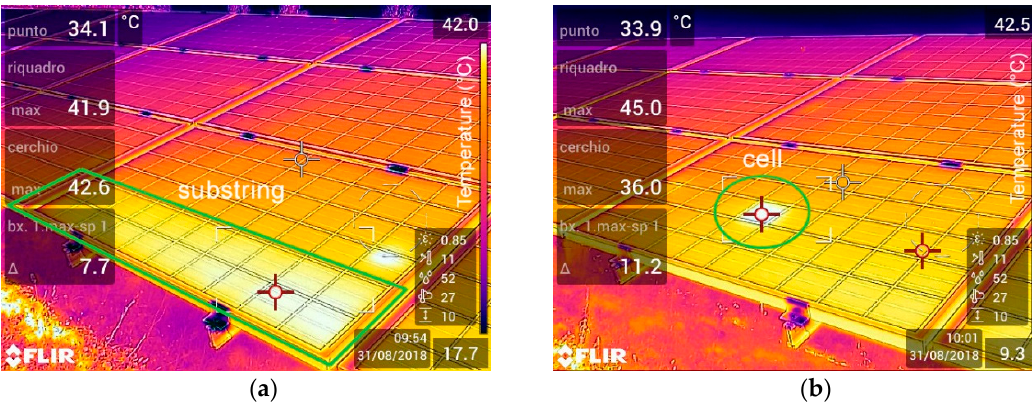
Figure 2. Thermal images collected from UAV. ( a ) Example of overheated cells, also called a hotspot, (Plant A), and ( b ) an example of an overheated module and string (Plant B).